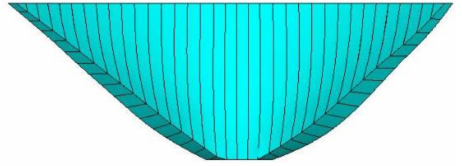
Figure 3. Distribution of the arch dam contraction joints.